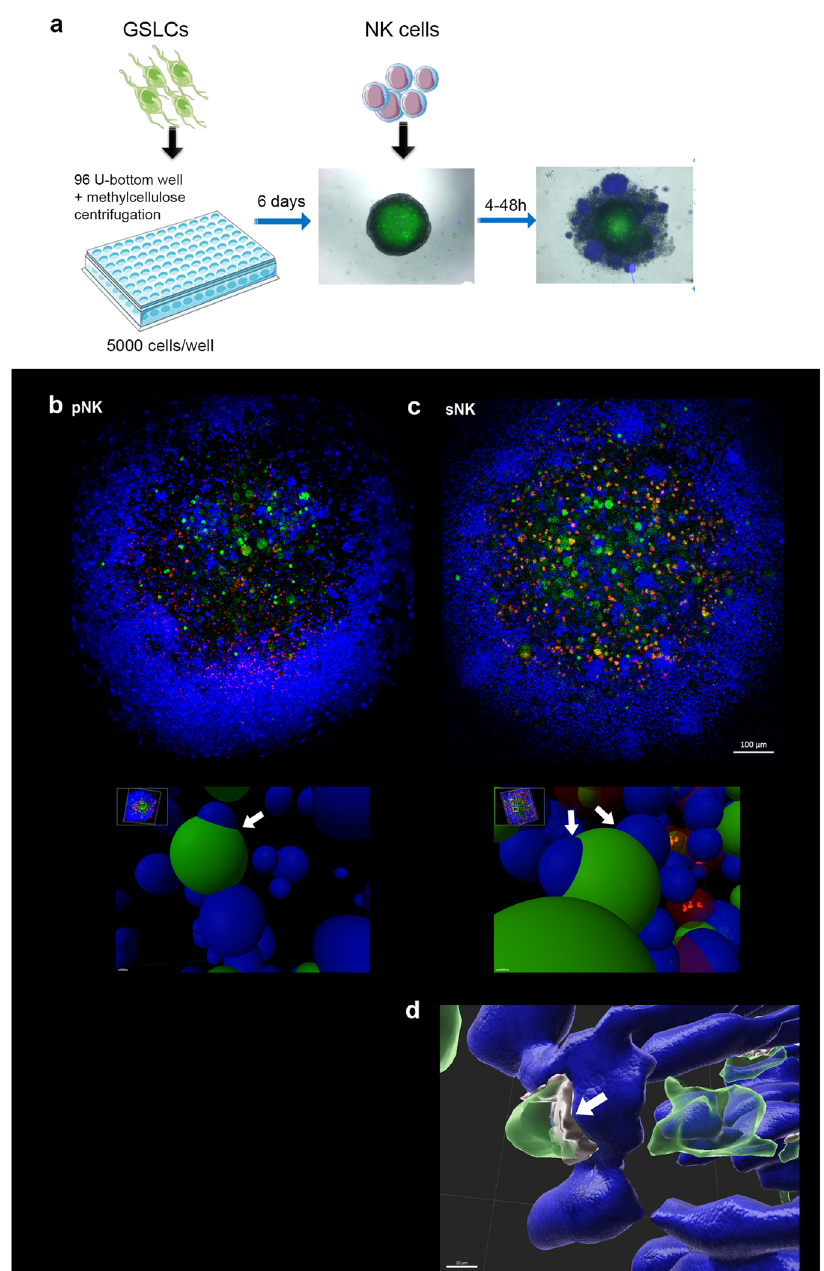
Fig. 3 NK cells (blue) penetrated into the GSLC tumorospheres (green) and directly interacted with tumor cells. IL-2 activated primary NK cells ( a , b ) or super-charged NK cells ( c ) were added to NCH421k tumorospheres in ratio 2.5:1 for 24h before images were taken by confocal microscope. Single focal plane ( z = 33 μ m) showed penetration of NK cells into the GSLC spheroid and co-localization of blue and green cells within spheroids ( upper b , c ). Spot analysis in Imaris softwareof selectedareas,where GSLCand NK cell signalsco-localized (arrows), revealed directNK-GSLC interactions ( lower b , c ). Surface rendering of GSLCs and NK cells in Imaris showed direct cellular interactions ( d ). Gray surfaces represents areas of green GSLC surfaces touching blue surface of NK cells (arrow). Red dots represent PI-positive dead cells. Scale bar = 100 μ m (upper b , c ), 10 μ m (lower b , c ) and 20 μ m ( d